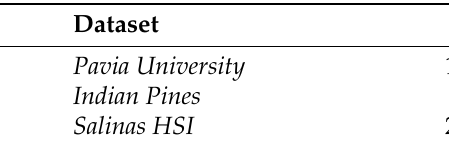
Table 1. Computational time in